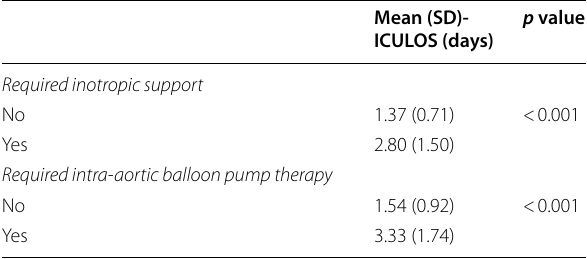
Table 6 Bivariate analysis of the cardiac surgical patients ICULOS (days) ( N =